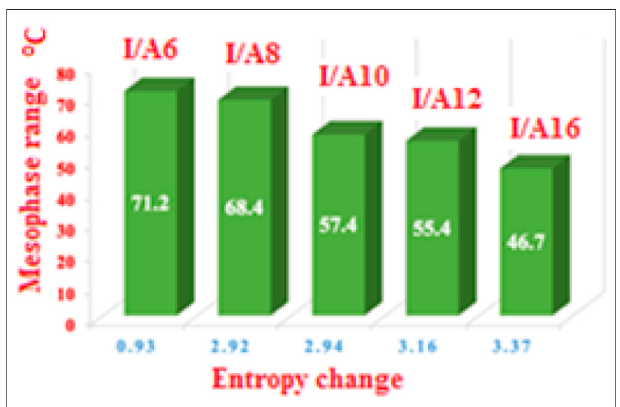
FIGURE 17 | Entropy changes as a function of the terminal alkoxy chain length and the mesophase range.